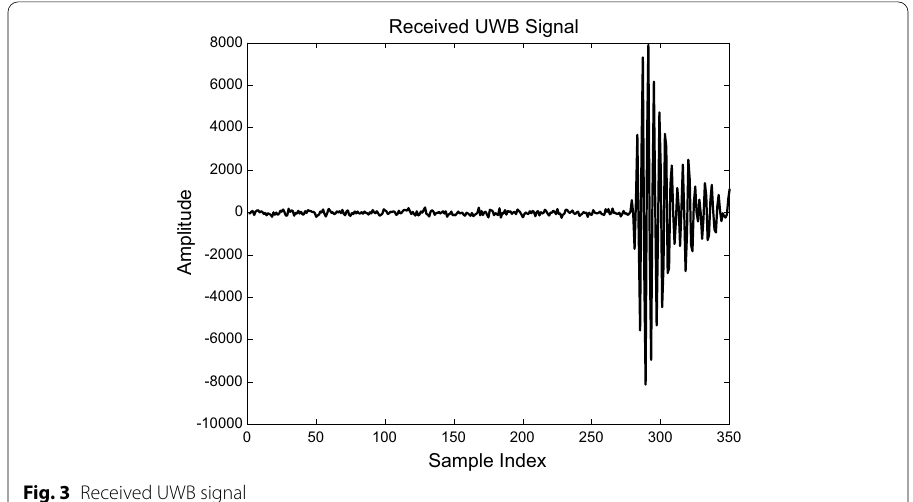
Fig. 3 Received UWB